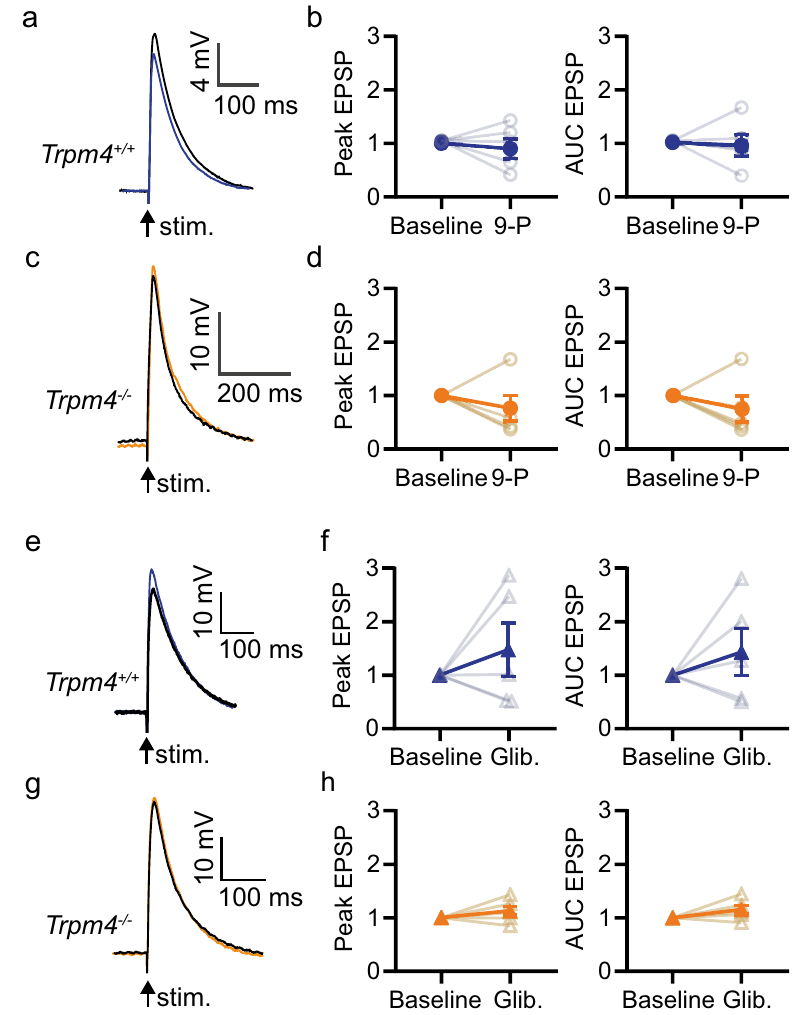
Figure 2. TRPM4 does not contribute to synaptic responses. ( a – d ) Effect of 9-phenanthrol (9-P, 30 µM) on EPSPs recorded from CA1 pyramidal neurons in acute slices from wildtype ( Trpm4 + / + ) or knockout ( Trpm4 –/– ) littermates. ( a , c ) Sample EPSPs before (blue/orange traces) or 20 min. after washing in 9-P (black). ( b , d ) Normalized peak and area under the curve (AUC) averaged from 5 min before (baseline) and the last 5 min in 9-P (n = 5, individual responses, mean ± SEM) ( e – h ) Effect of glibenclamide (Glib. 20 µM) on EPSPs recorded from CA1 pyramidal neurons in slices from wildtype ( Trpm4 + / + ) or knockout ( Trpm4 –/– ) littermates. ( e , g ) Sample EPSPs before (blue/orange traces) or 20 min. after washing in glibenclamide (black). ( f , h ) Normalized peak and area under the curve (AUC) averaged from 5 min before (baseline) and the last 5 min in glibenclamide (n = 6, individual responses, mean ± SEM). Non-normalized data and Cumming’s plots are shown in Supplemental Fig.